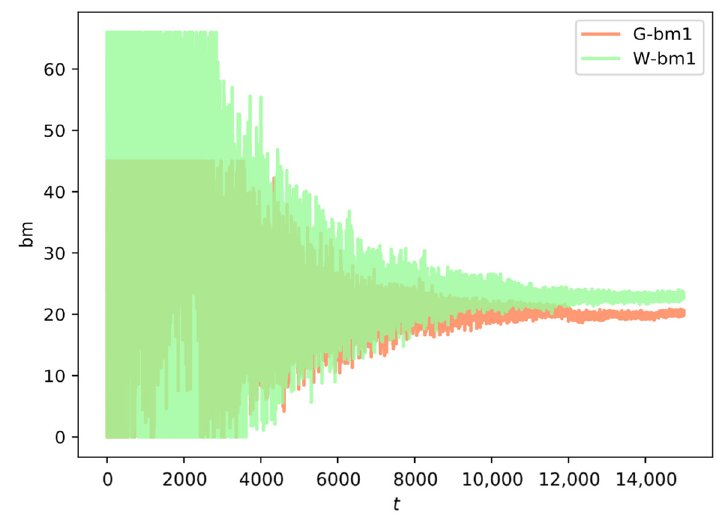
Figure 6. Load varies with market clearing price.